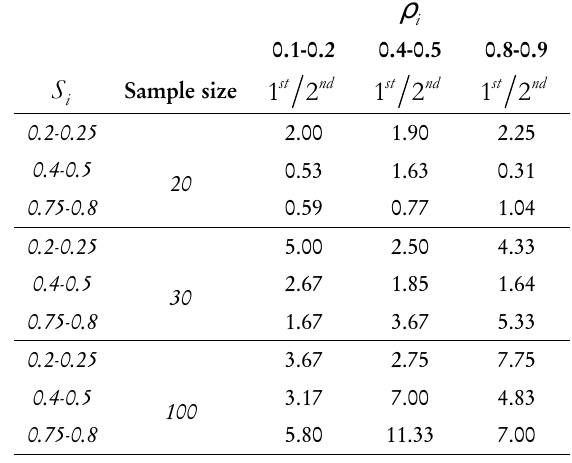
r i and sample size - Normal error component